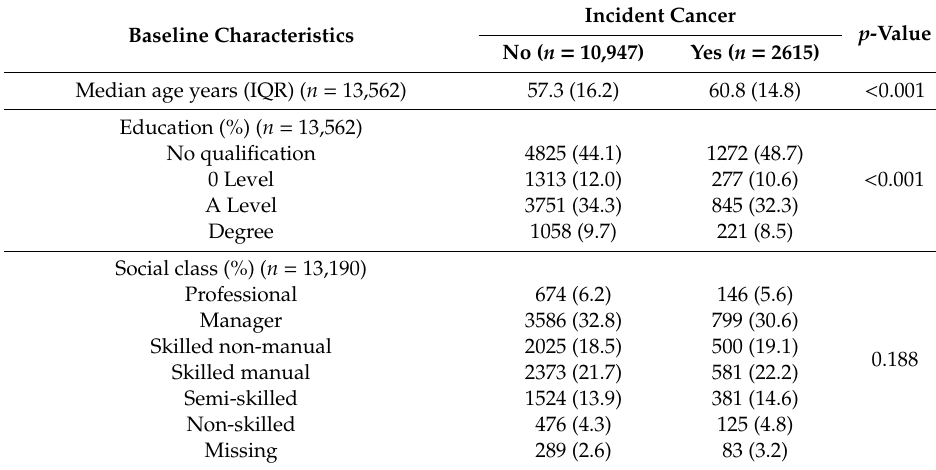
Table 1. Baseline characteristics of 13,562 women of the EPIC-Norfolk according to whether participants did or did not have incident